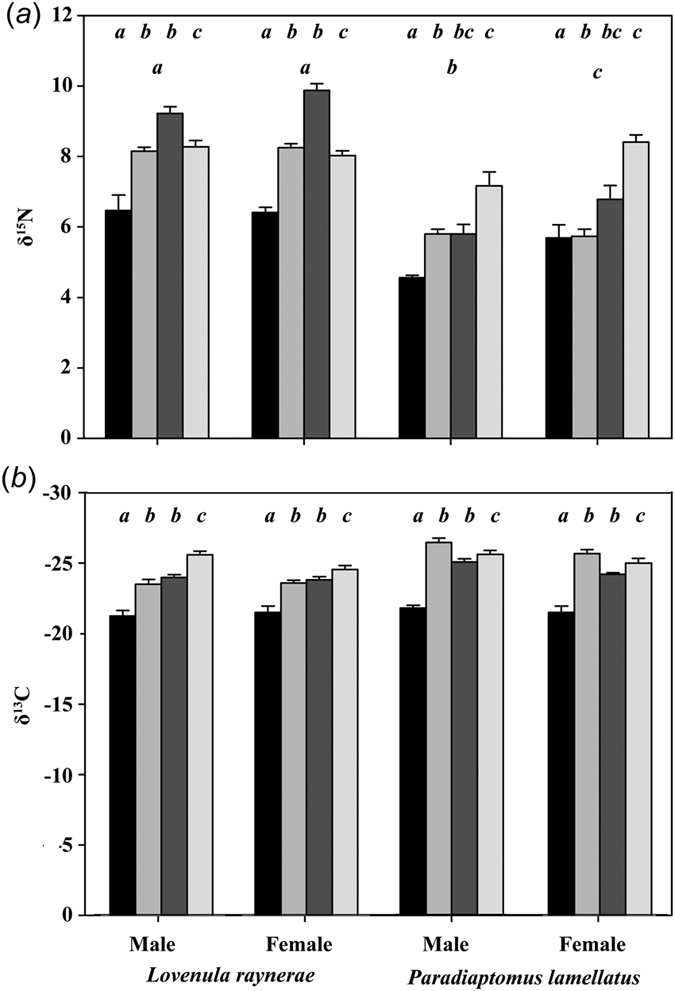
Temporal fluctuations in (a) mean δ15N (‰) and (b) mean δ13C (‰) of Paradiaptomidae copepods: Lovenula raynerae and Paradiaptomus lamellatus over the hydroperiod (surveys 1, 2, 3 and 4) in an ephemeral pond.